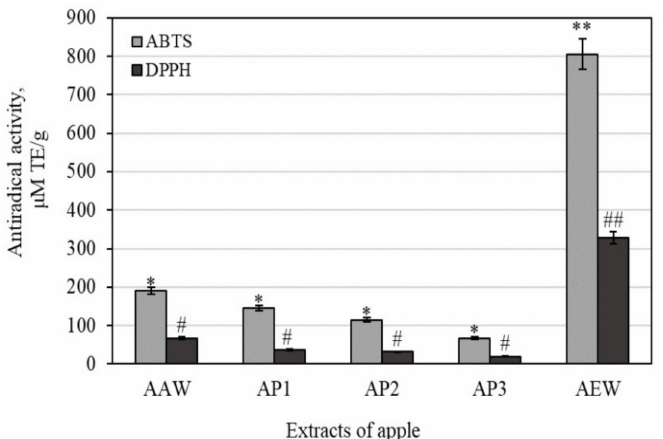
Figure 5. Antiradical activity of whole apple and apple peel extracts evaluated via ABTS and DPPH free radical scavenging assays. Different signs (* and #) indicate statistically significant differences at p > 0.05, according to Tukey’s multiple comparison test.